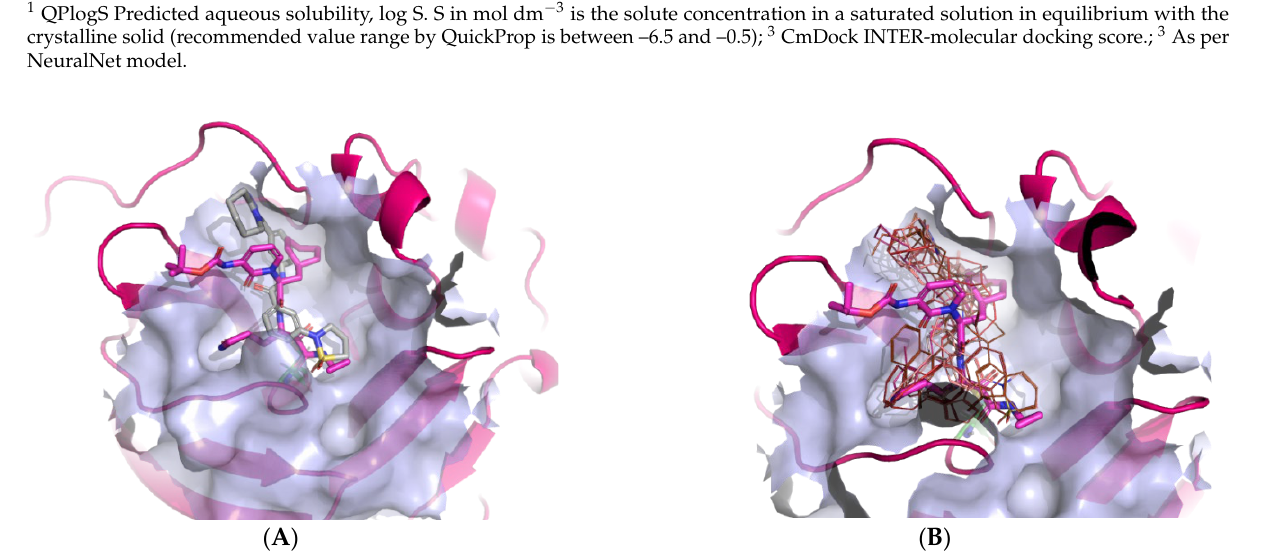
Figure 5. Calculated bound conformations in the 3CL pro active site of the top-scoring hit compounds. Protein is presented in a cartoon model coloured pink with an emphasised molecular surface in light-blue colour. ( A ); the reference OEW ligand is presented in stick model cored magenta, while the top-scoring hit is coloured grey. ( B ) the reference OEW ligand is presented in stick model cored magenta while the top 10 scoring compounds are depicted in red-coloured line representations to emphasise their analogous binding mode in the P1-P2-P3 pockets of the active site. Table 2. Identified top-scoring compounds in the HTVS on the SARS-CoV-2 main protease for further compound priori- tisation in biological evaluation experiments.